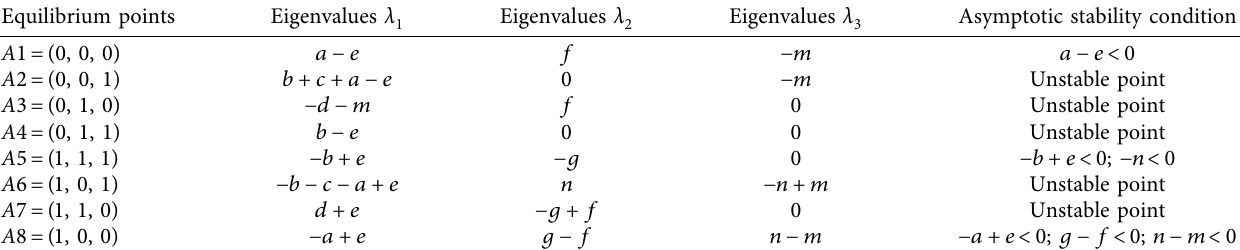
Table 2: Eigenvalues and asymptotic stability conditions of the Jacobian